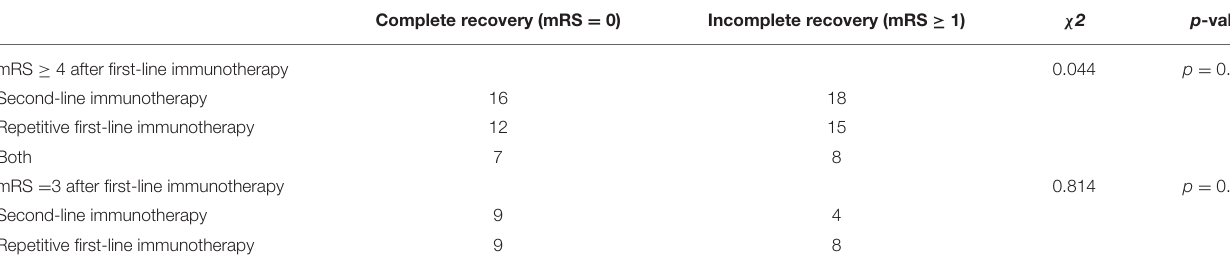
TABLE 5 | Comparison of effects of second-line and repetitive first-line immunotherapy on patient outcome.